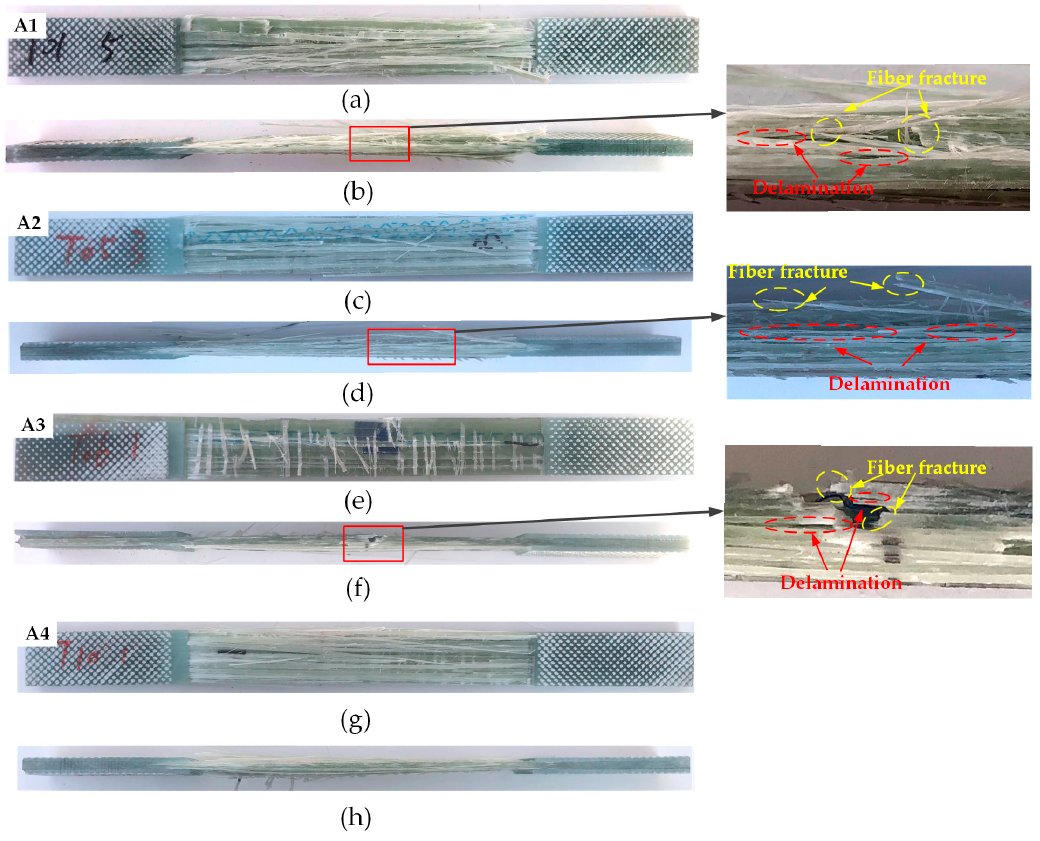
Figure 6. Specimen failure morphologies. ( a ) A1 specimen failure front view; ( b ) A1 specimen failure side view; ( c ) A2 specimen failure front view; ( d ) A2 specimen failure side view; ( e ) A3 specimen failure front view; ( f ) A3 specimen failure side view; ( g ) A4 specimen failure front view; ( h ) A4 specimen failure side view.